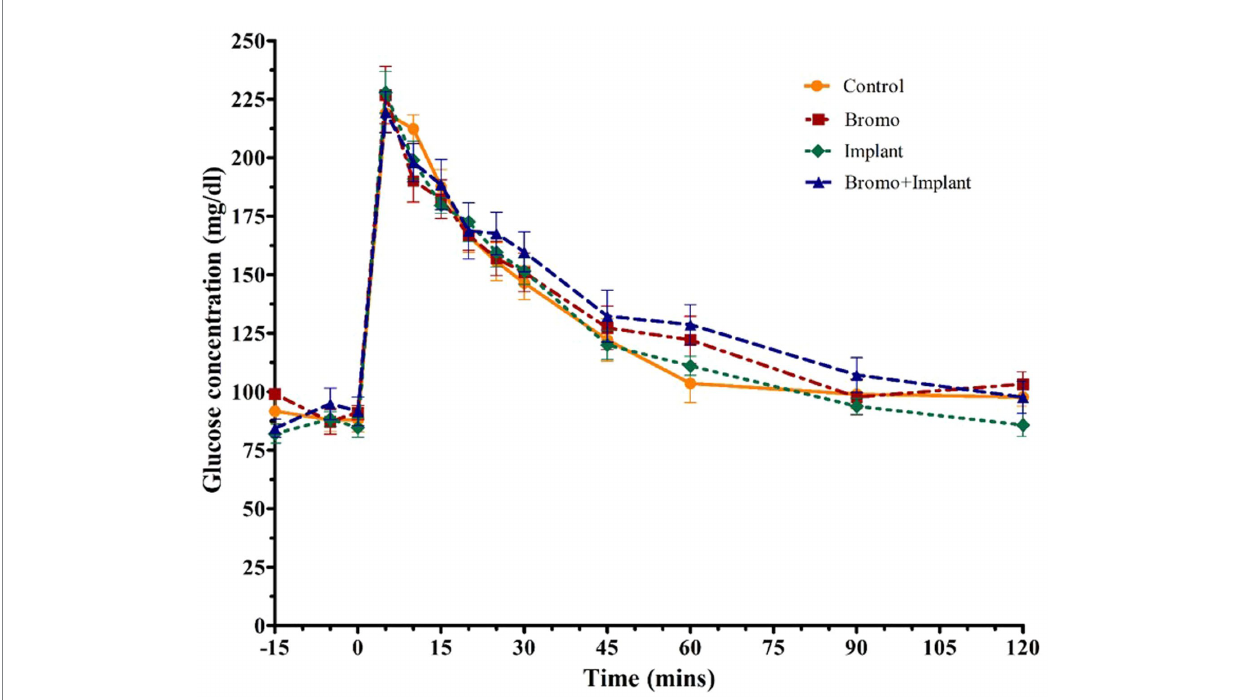
FIGURE 2 Mean plasma concentration of glucose (mg/dL). Values are means + SE of plasma glucose concentrations during intravenous glucose tolerance test (IVGTT) for steers treated with bromocriptine injections and estradiol/TBA implants performed on d 35. Used to determine area under the curve which tended to be higher with bromocriptine treatment ( p = 0.09) and peak height. Time point 0 represents sample taken immediately before intravenous glucose bolus administration (0.25 g/kg BW). Area under the curve and peak height were analyzed as a randomized complete block, terms of the model included bromo, implant, and their interactions, in a 2×2 factorial structure. n = 8 for all treatments.